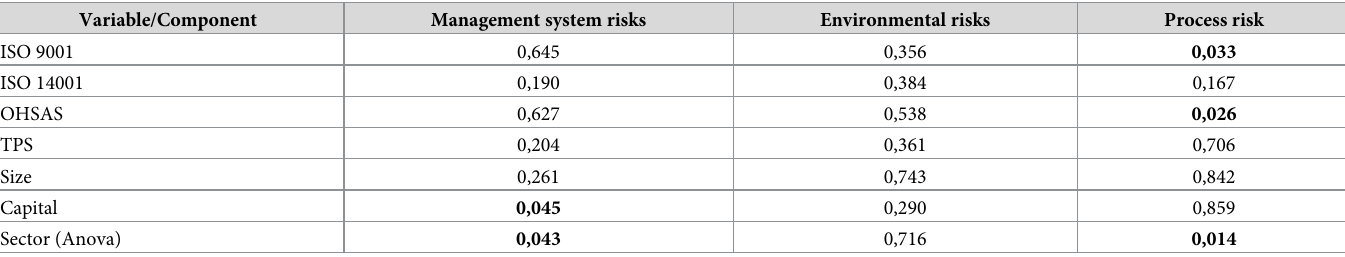
Table 5. Resulting